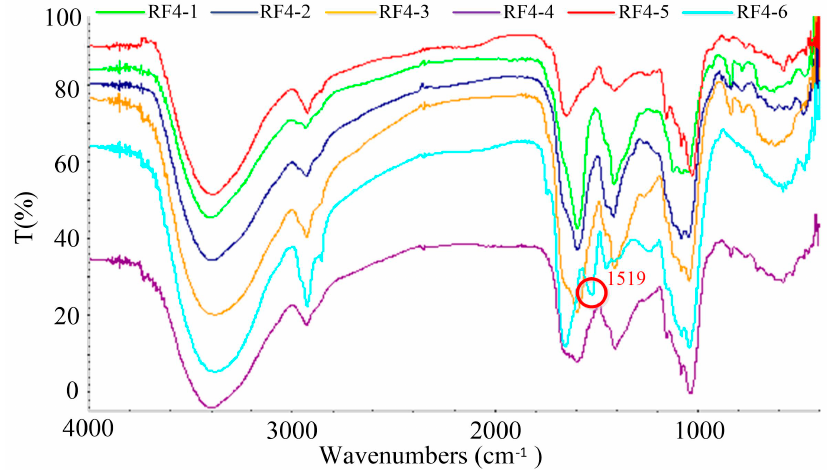
Figure 7. FT-IR spectrum of different MW fractions obtained from RF4 by ultrafiltration.